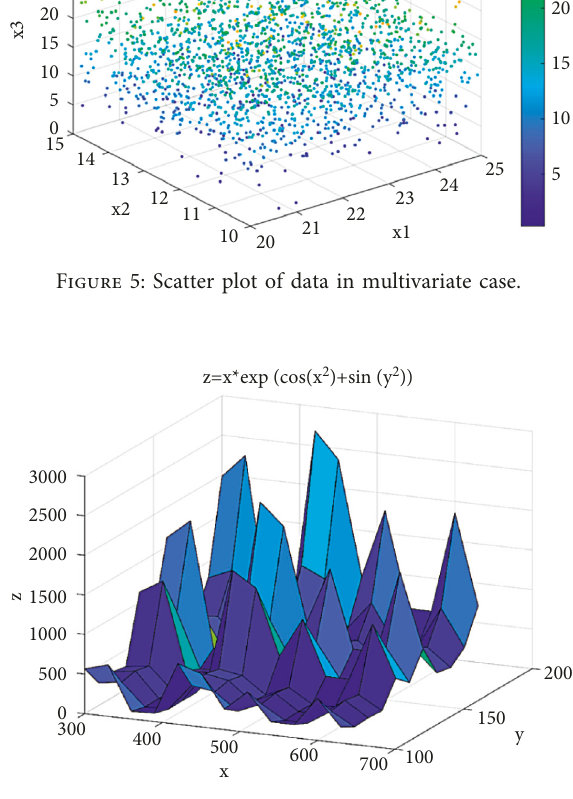
Figure 6: Correspondence graph between area and yield and label value.